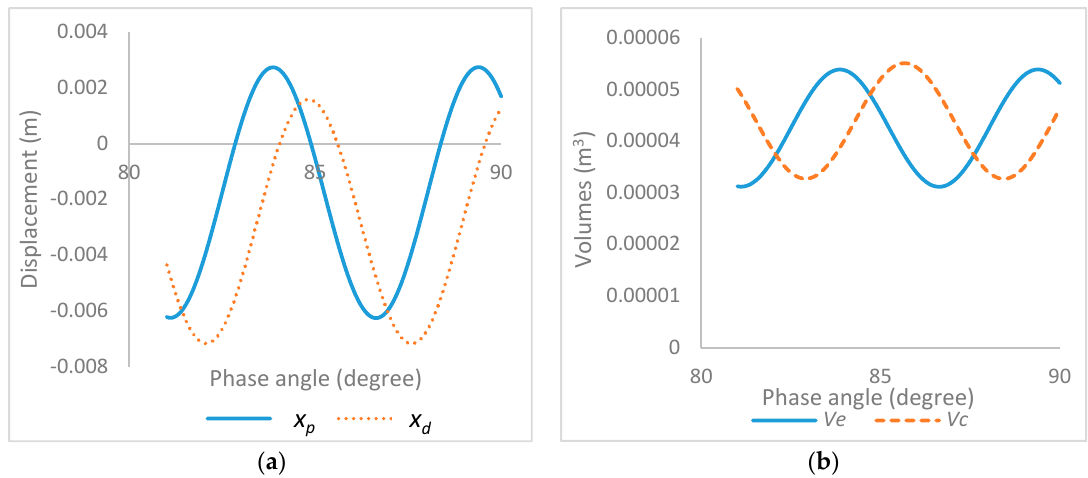
Figure 4. ( a ) Displacement of piston and displacer against phase angle; ( b ) Expansion and compression volumes against phase angle.